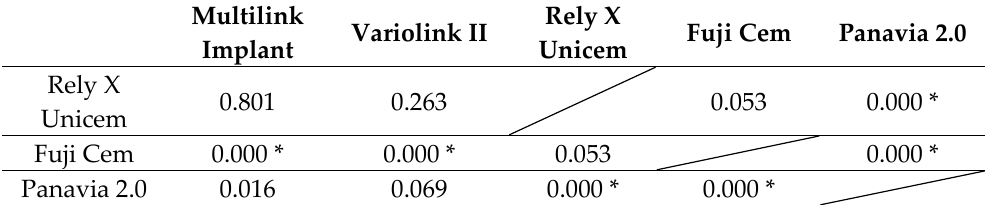
Table A6. Comparison of the different adhesives during the pull-off test: Celtra Duo. Table A6. Cont.